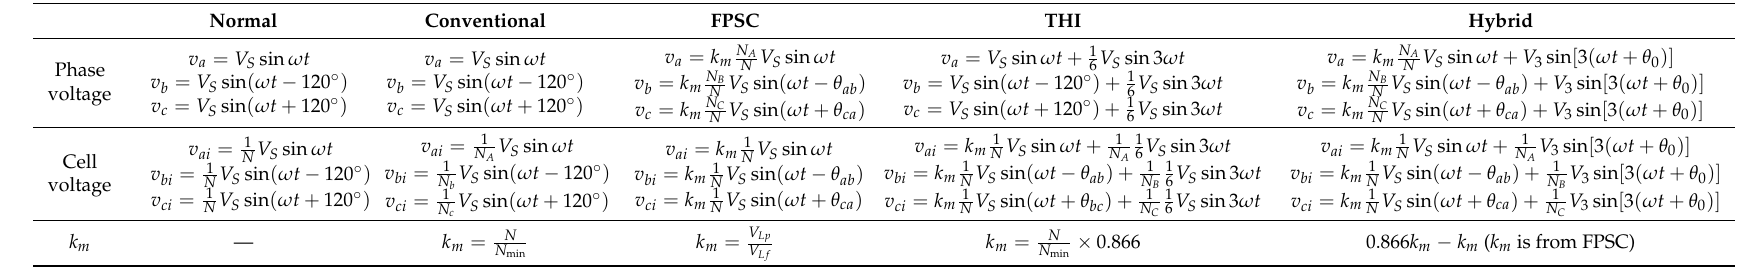
Table 2. Comparison of different fault-tolerant control